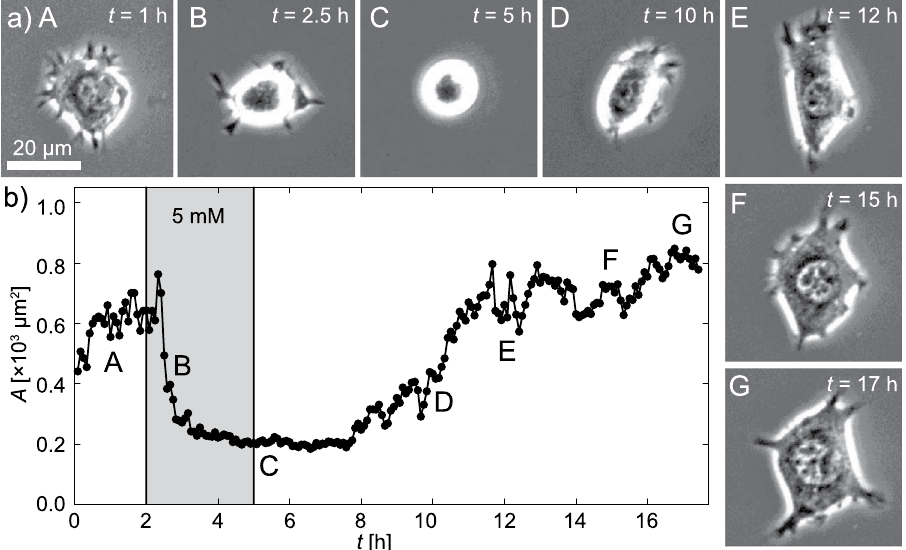
Figure 6. Reversible switching of cell morphology by mechanical commands. ( a ) Some representative phase contrast images are presented in subpanels A – G. C2C12 cells were exposed to medium containing 5 mM of β CD from t = 2 to 5 h (shaded time zone). ( b ) Projected area A of C2C12 plotted over time. The response of C2C12 to the substrate “softening” from E ≈ 11 to 6 kPa occurred much faster than the reverse reaction. The lag time before the cell started responding was also found to be much shorter for the softening. (See Supporting Information Fig. S2 for other